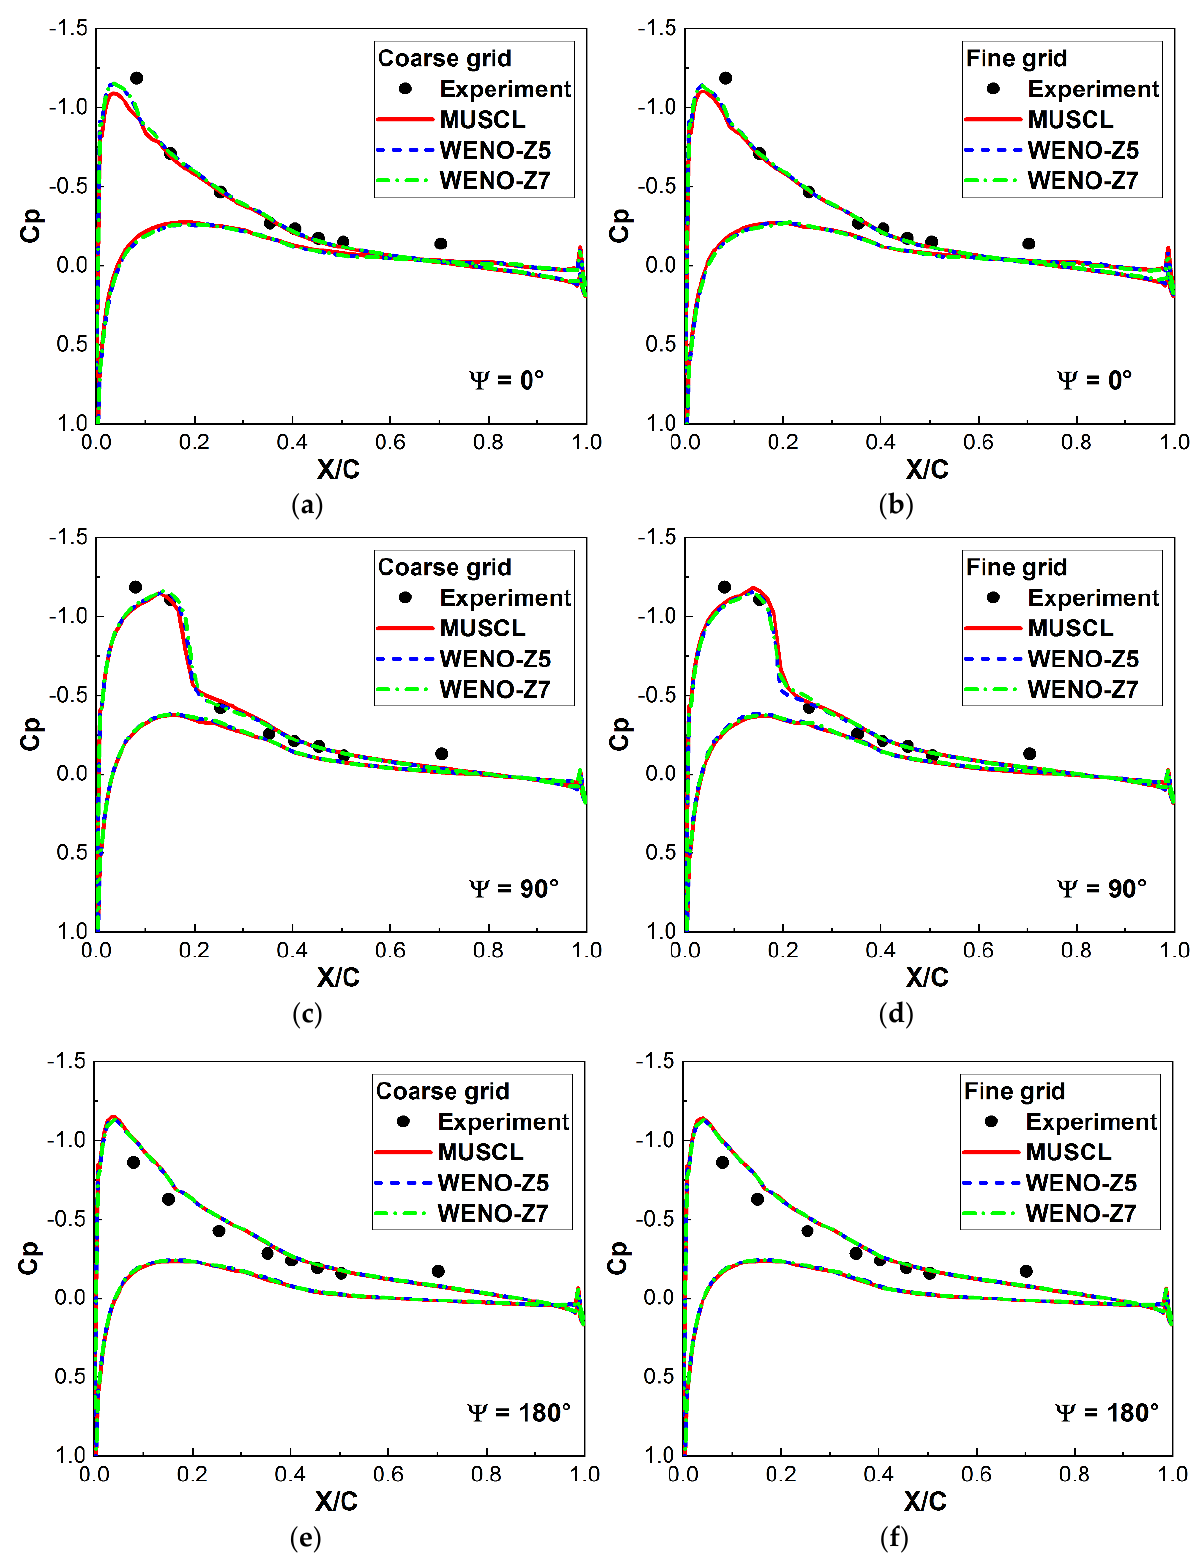
Figure 8. The pressure coefficients of the OLS rotor blade (r/R = 0.955) for the coarse and fine grids obtained from the experiment and the WENO and MUSCL schemes: ( a ) ψ = 0 ◦ (coarse grid); ( b ) ψ = 0 ◦ (fine grid); ( c ) ψ = 90 ◦ (coarse grid); ( d ) ψ = 90 ◦ (fine grid); ( e ) ψ = 180 ◦ (coarse grid); ( f ) ψ = 180 ◦ (fine grid).